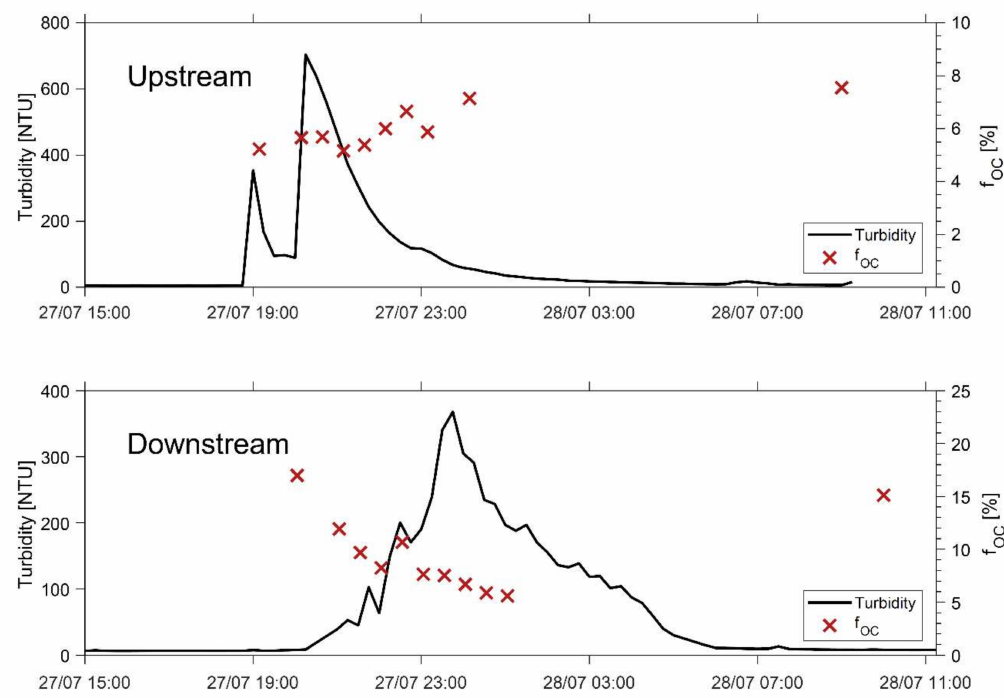
Figure 4. Time course of turbidity [NTU] and f oc (%) for the upstream and downstream sampling